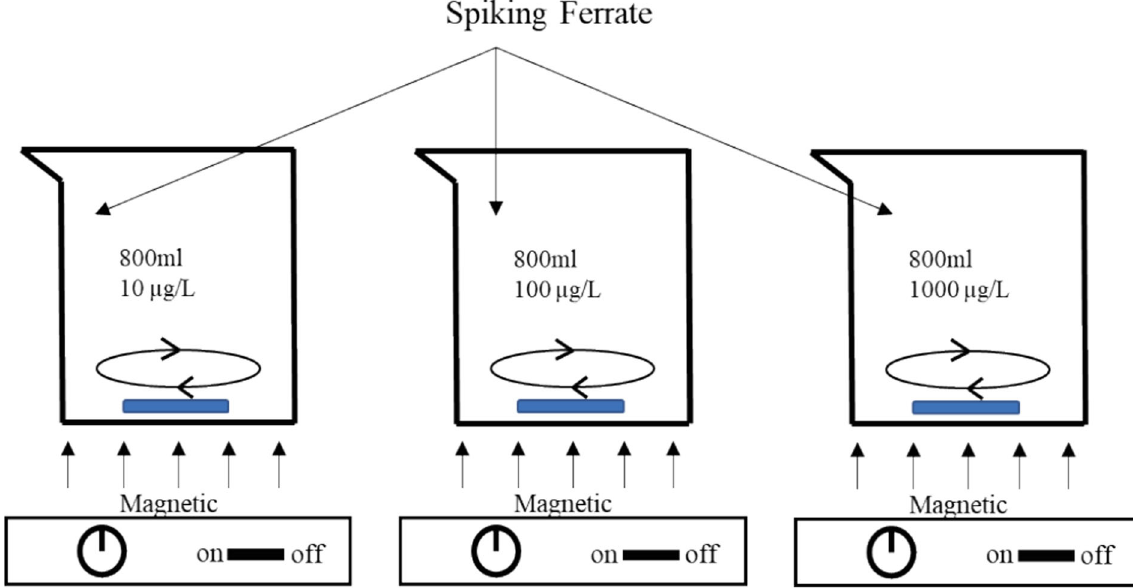
Fig. 5 Schematic jar test facilities used for ferrate treatment. Schematic jar test facilities used for ferrate